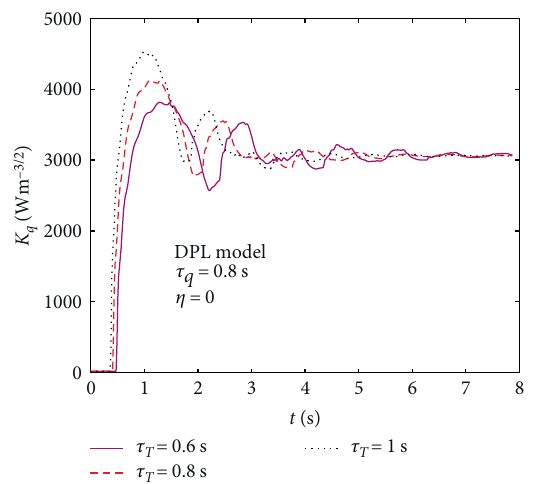
Figure 4: Effect of on HFIF for a homogeneous cylinder based 𝜏 𝑞 on the C–V model.